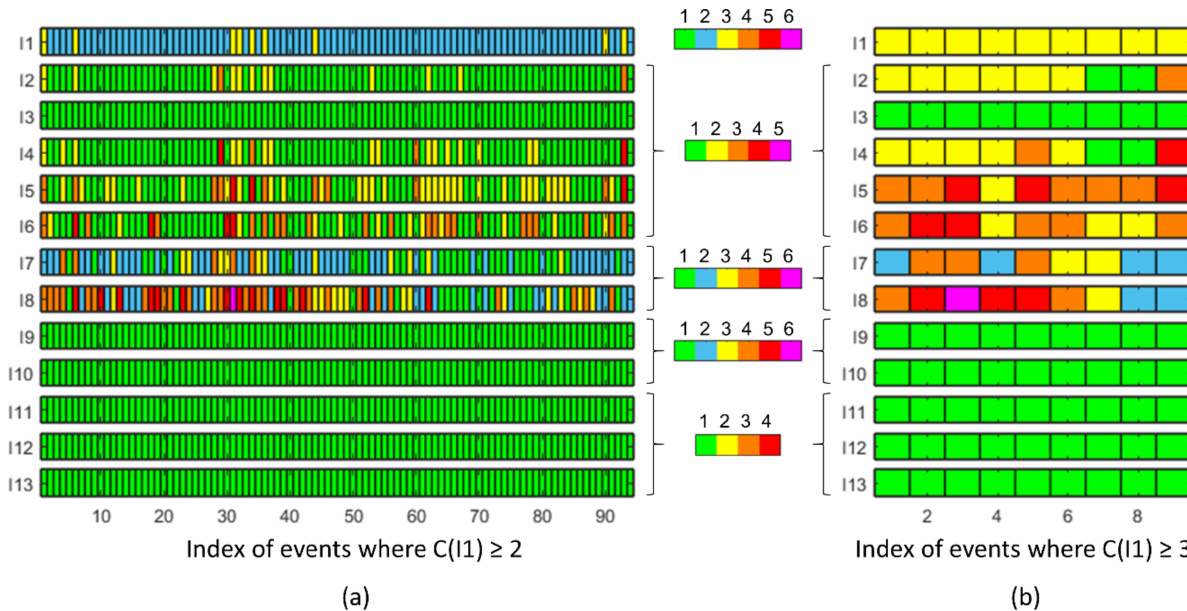
Figure 13. Hindcasts of indicators I 1 to I 13 for cases where ( a ) there are at least a few instances of overtopping (i.e., C(I 1 ) ≥ 2) and ( b ) the flood is at least of minor intensity (i.e., C(I 1 ) ≥ 3). The colour bars correspond to the colour code defined for each indicator (see Figure 3). The dates corresponding to events 1 through 9 in panel ( b ) are (in